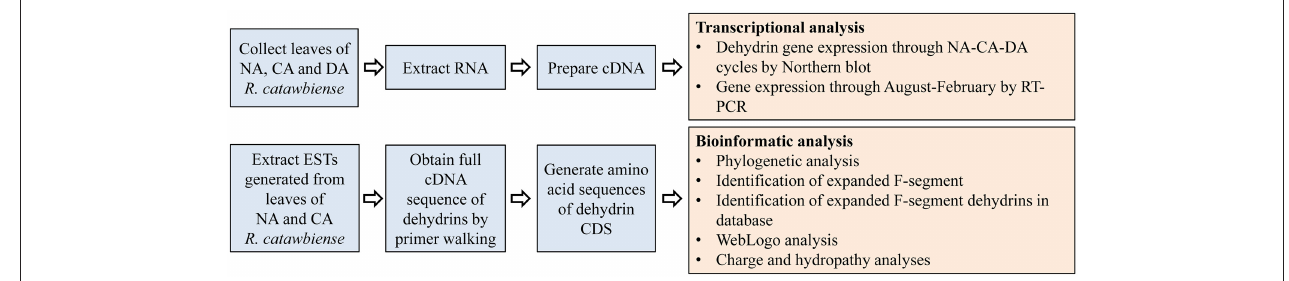
FIGURE 1 | Diagram of the outline for the experimental design and analyses.: CA, cold-acclimated; DA, de-acclimated; EST, expressed sequence tag; NA,